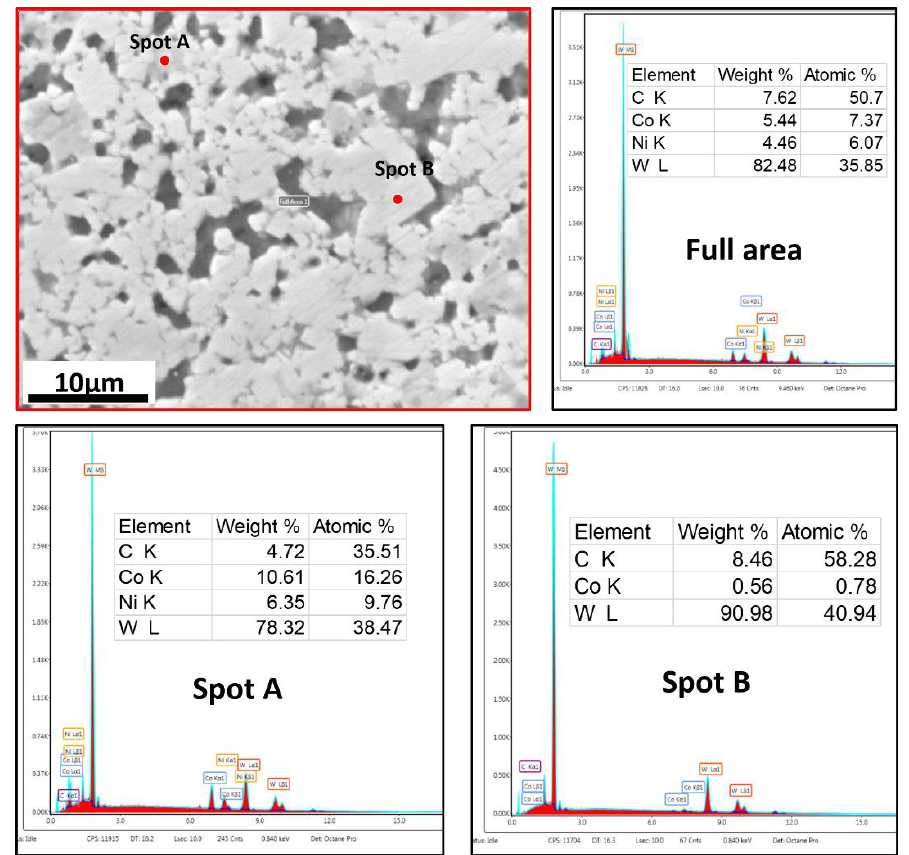
Figure 13. EDS analysis of the consolidated WC-Co-TaC-NbC-5 wt% Ni with 5 wt% Y 2 O 3 .